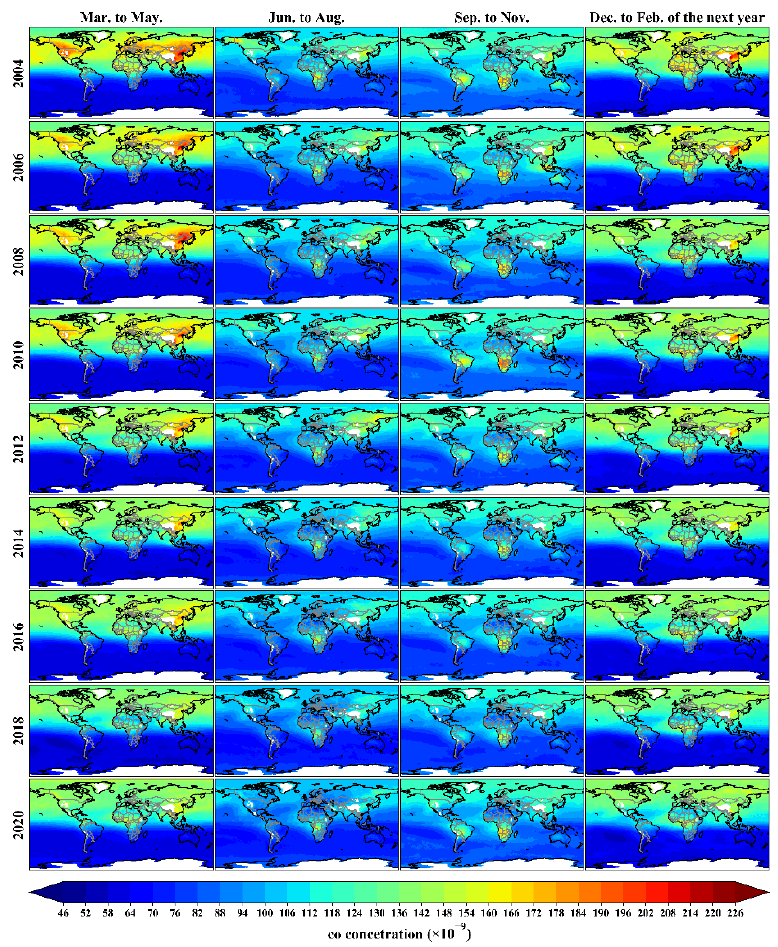
Figure 5. From 2003 to 2020, the Global CO concentration is 850 hPa, and the atmospheric pressure layer has spatial distribution in even seasons.